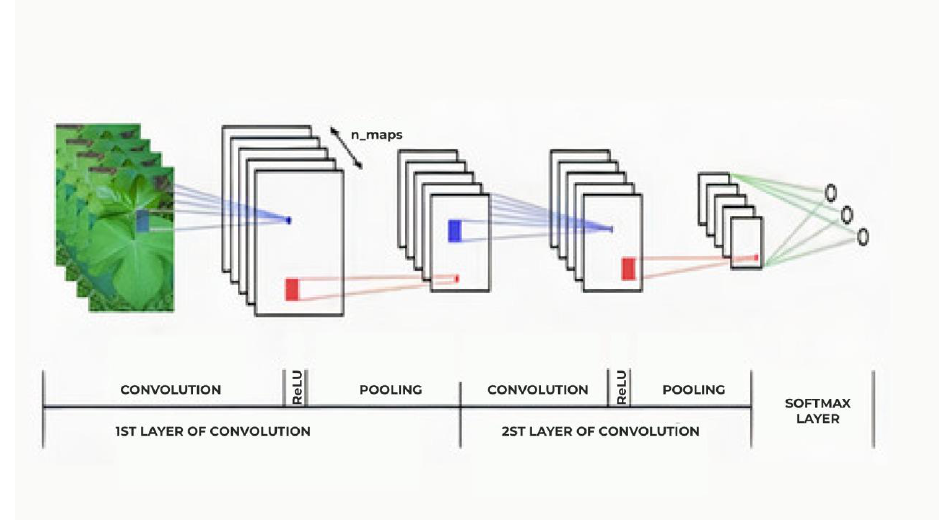
Figure 3. Diagram of a Convolutional Neural Network. (Reprinted with permission from ref. [42]).